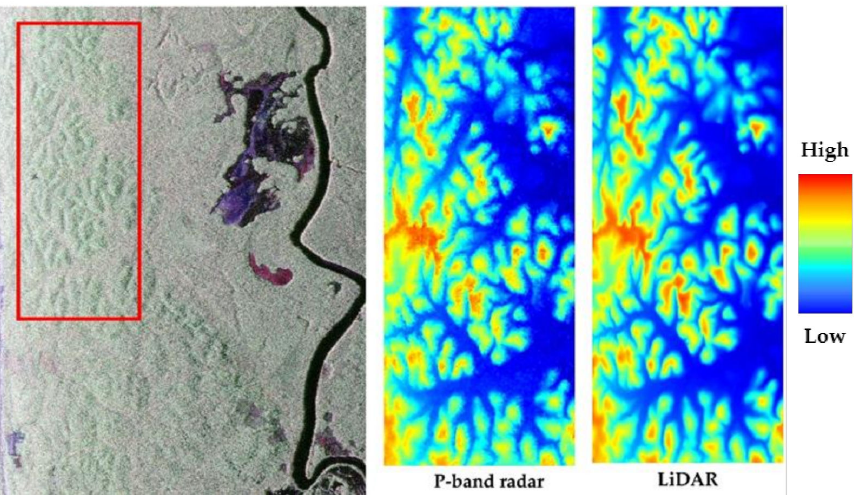
Figure 3. Subset of the original image stack Pauli RGB (red frame, left ), DTM obtained by P-band radar tomography ( center ) and existing lidar DTM ( right ).